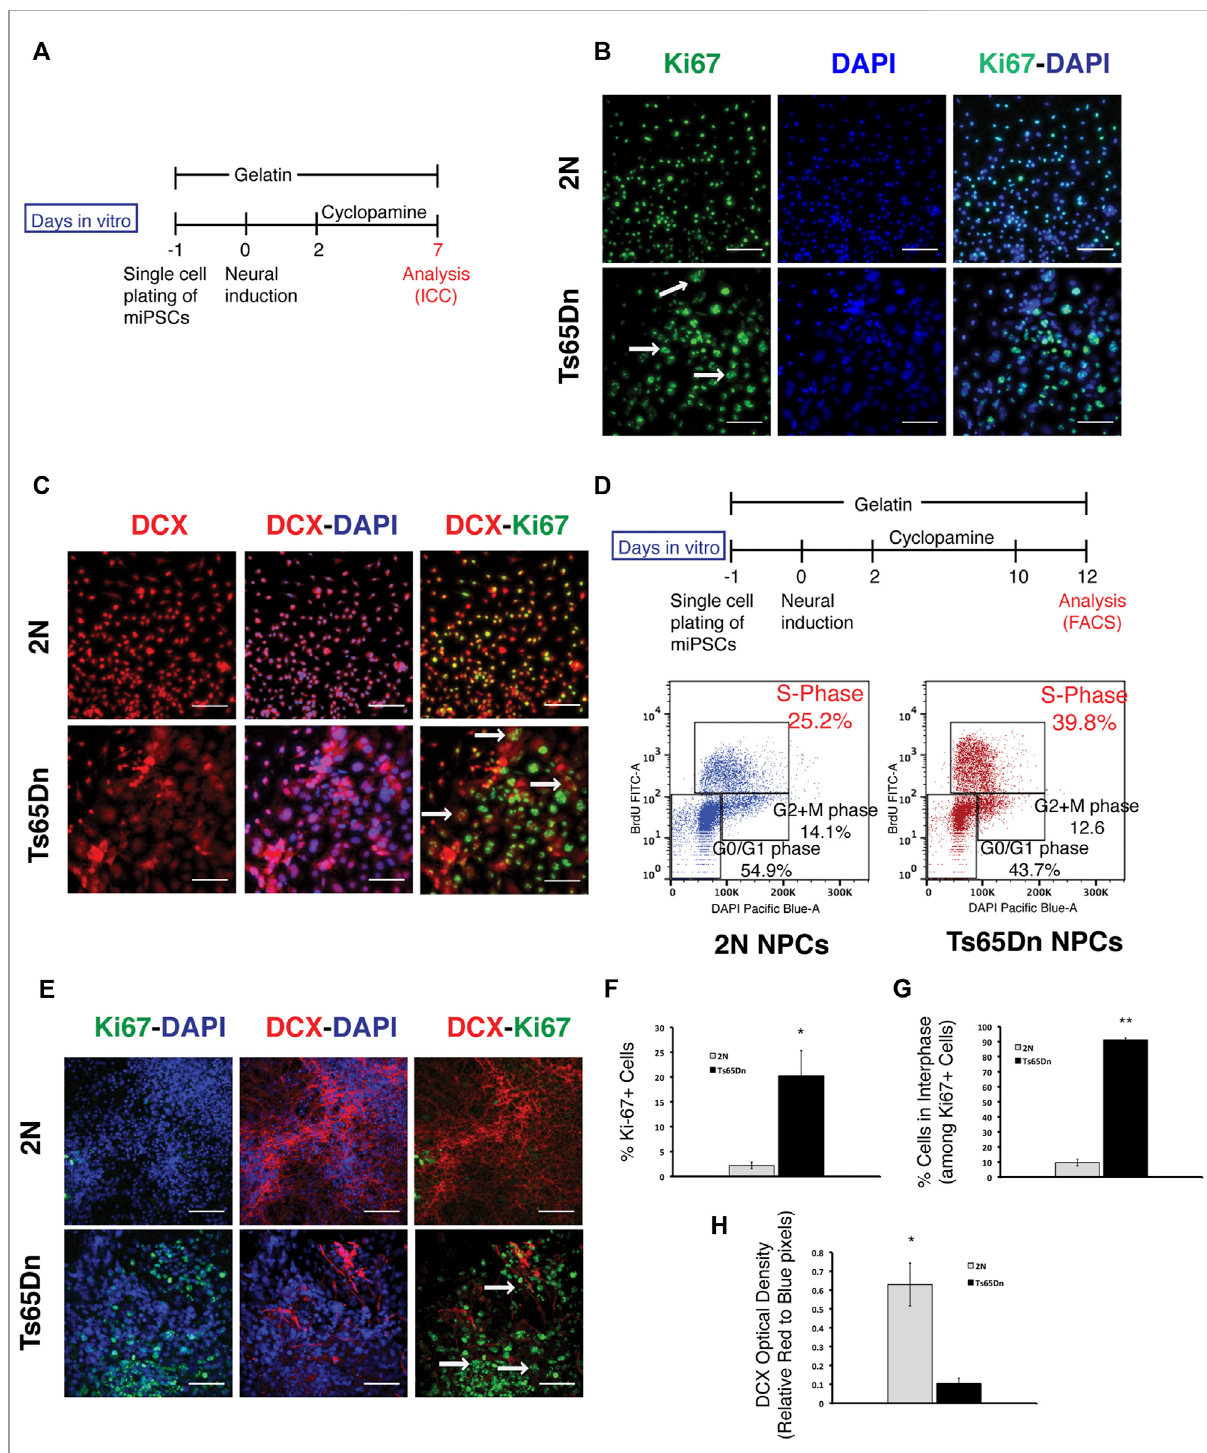
FIGURE 3 Analysis of mouse progenitor cells during neural differentiation. (A) Schematic representation of progenitor differentiation from mouse iPSCs. (B) Ki67staininganditsoverlaywithDAPIstainednucleionDIV7.CellsintheMphaseofthecellcycleshowwholenucleiexpression,whilecellsinthe interphase (G1/S/G2 phase) show a punctate pattern. Examples of Ki67 + cells with punctate expression patterns are shown with an arrow. (C) Progenitor cells were stained with Doublecortin (DCX) at DIV 7 of differentiation. Representative images showing DCX (red) expression.